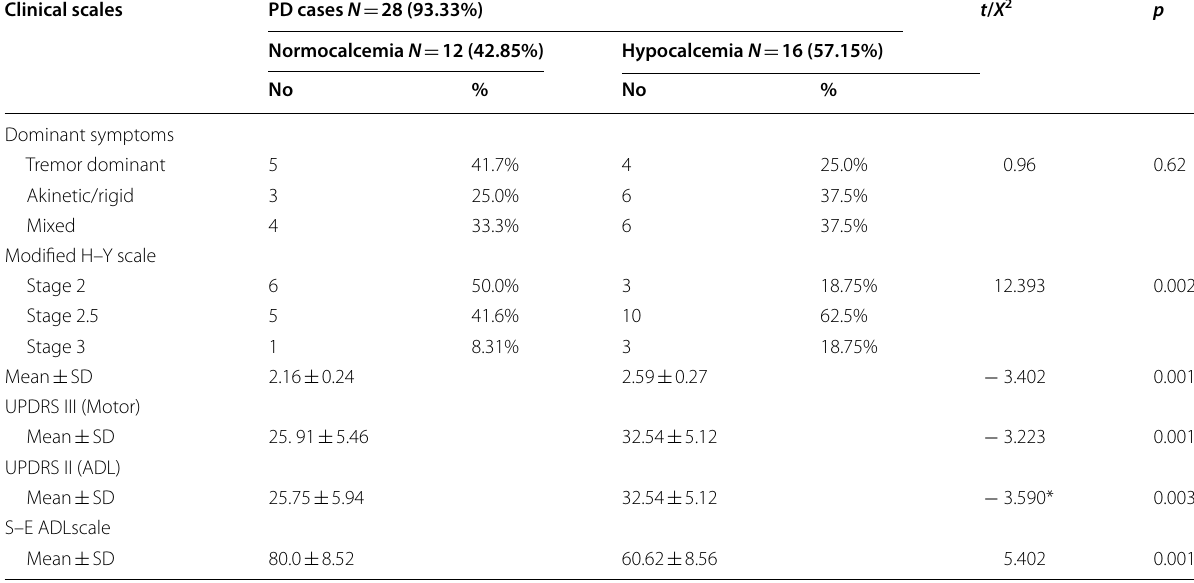
Table 4 Comparison between PD patients with normal calcium level and PD patients with hypocalcemia regarding clinical scales